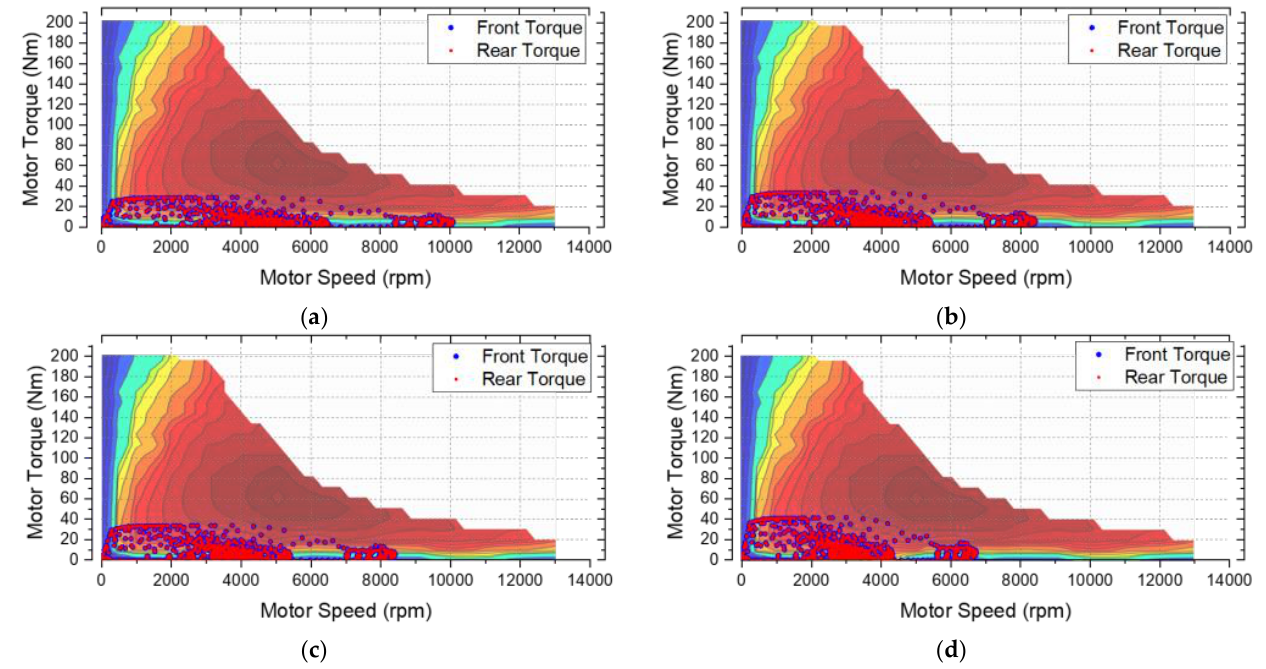
Figure 4. DER of 60 kW motor according to the following gear ratios: ( a ) 12:1; ( b ) 10:1; ( c ) 8:1; ( d ) 5:1.